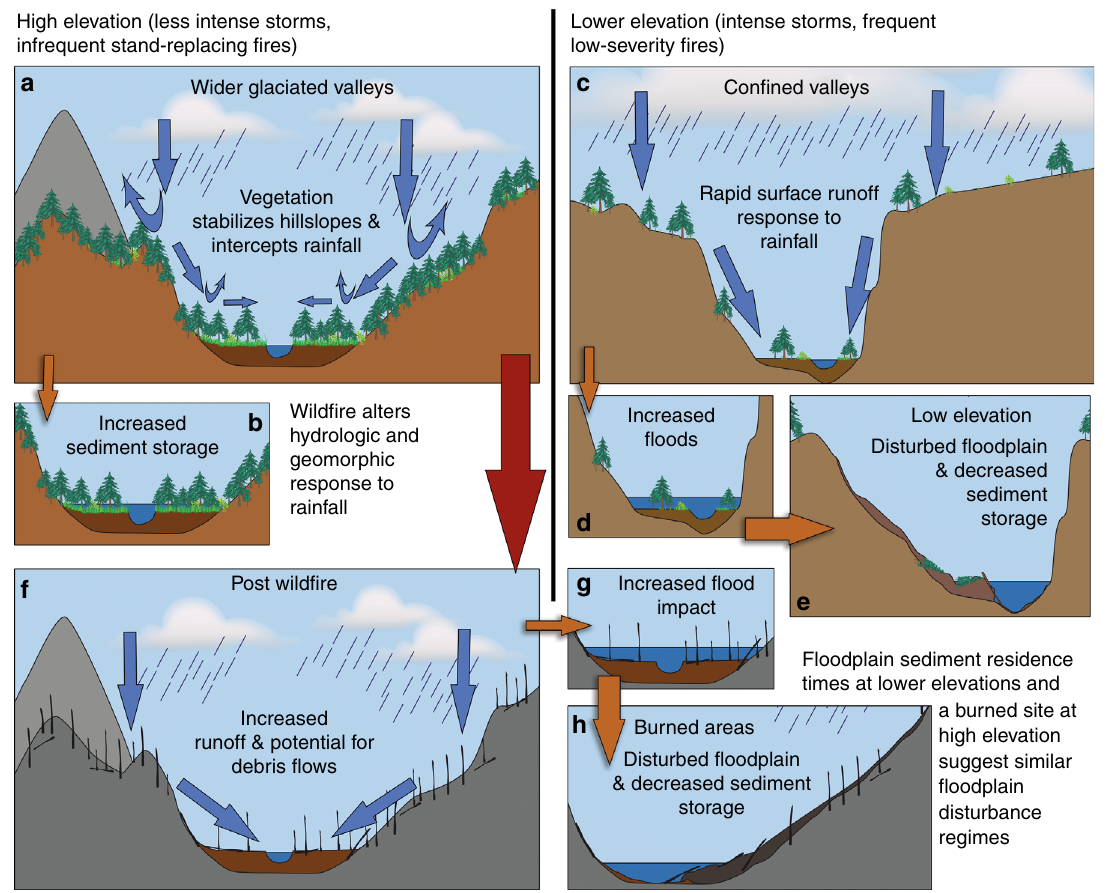
Fig. 8 Forest characteristics and hydrogeomorphic response. Conceptual diagram illustrating the in fl uence of differences in hydrologic and geomorphic response on fl oodplain sediment residence time along partially con fi ned and uncon fi ned valleys in the Colorado Front Range. Abundant vegetation in the subalpine zone with low fi re frequency intercepts rainfall and slows runoff response, which stabilizes hillslopes ( a ) and results in stable fl oodplains and sediment storage ( b ). Tighter coupling between hillslopes, less vegetation cover, increased fi re frequency, increased likelihood of large convective thunderstorms, and more rapid rainfall – runoff response in narrowly con fi ned valleys in the montane zone ( c ) result in increased fl ood magnitude ( d ), increased potential for debris fl ows and slope failures, and more frequent fl oodplain disturbance ( e ). Decreased vegetation cover and interception and increased rainfall – runoff response in the subalpine zone following wild fi re ( f ) results in increased fl ood magnitude ( g ), potential for debris fl ows, and fl oodplain disturbance, and decreases in resulting fl oodplain sediment residence time ( h ). Images depict differences in geometry and hydrogeomorphic response along relatively partially con fi ned and uncon fi ned valley segments representative of study sites at high and low elevation. However, charcoal samples were not analyzed from highly con fi ned sites with little to no fl oodplain present. Although more con fi ned valley segments exist at both high and low elevation, valleys below the Pleistocene terminal moraine typically do not contain wide uncon fi ned valleys in the study